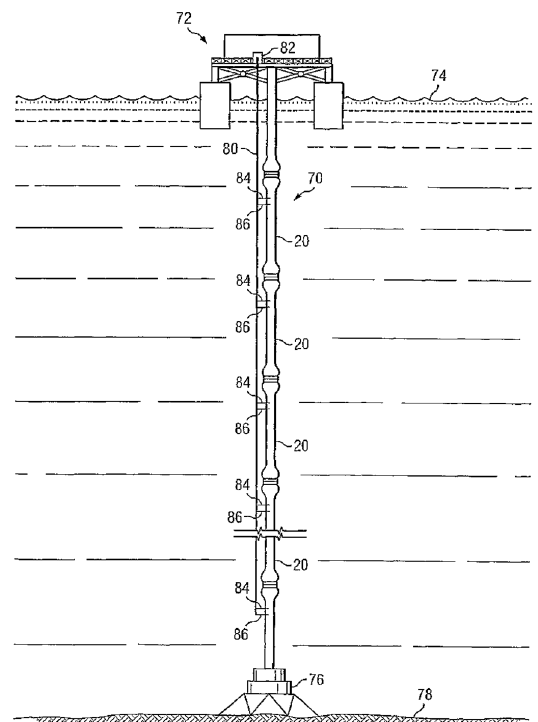
Figure 14. Illustration of the monitoring module attached to the surface controller in the patent for composite riser monitoring devices and methods (Patent No.: US20050100414, Courtesy: Conoco Phillips Company). Table 4. Patent list for innovations in monitoring devices with methods for composite risers and steel risers .